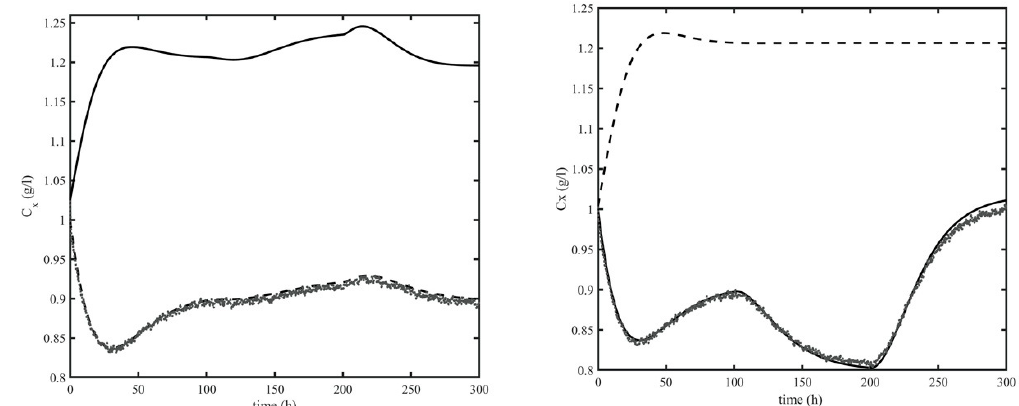
Figure 1. Dynamic response of biomass concentration calculated with the virtual plant (continuous line), open-loop model (dashed line) and geometric observer (GO) (dotted grey line) for structure φ 1 along trajectory T1 ( left panel) and T2 ( right panel).